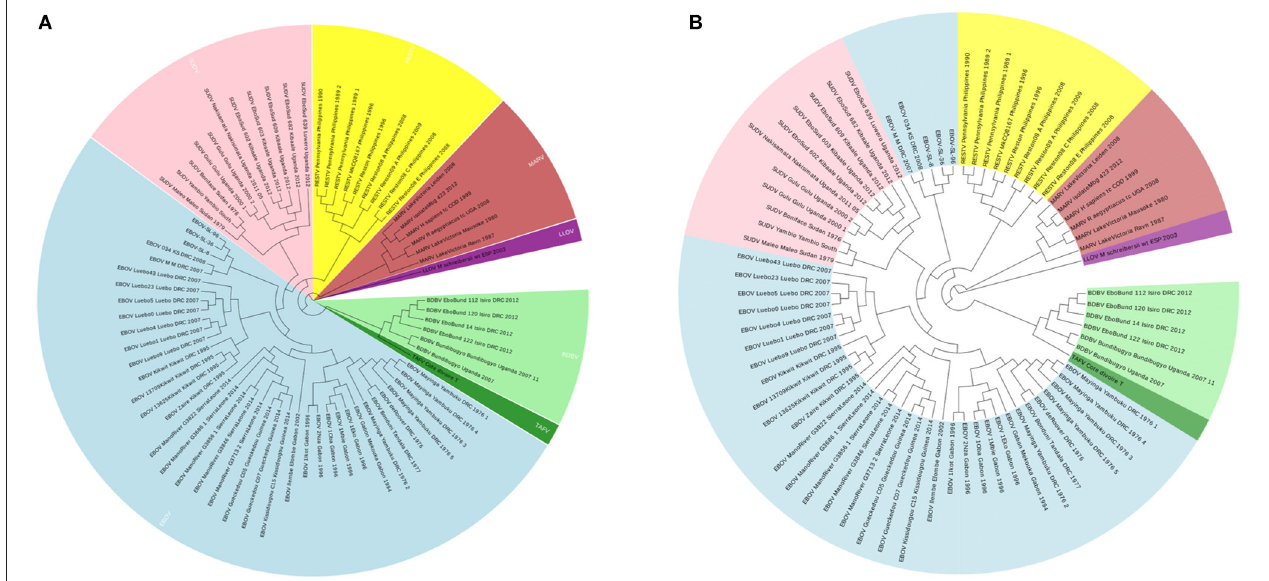
FIGURE 6 | (A) The phylogenetic UPGMA tree using ANV method on Ebolaviruses dataset. (B) The phylogenetic UPGMA tree using the traditional Natural Vector (NV) method on Ebolaviruses dataset.